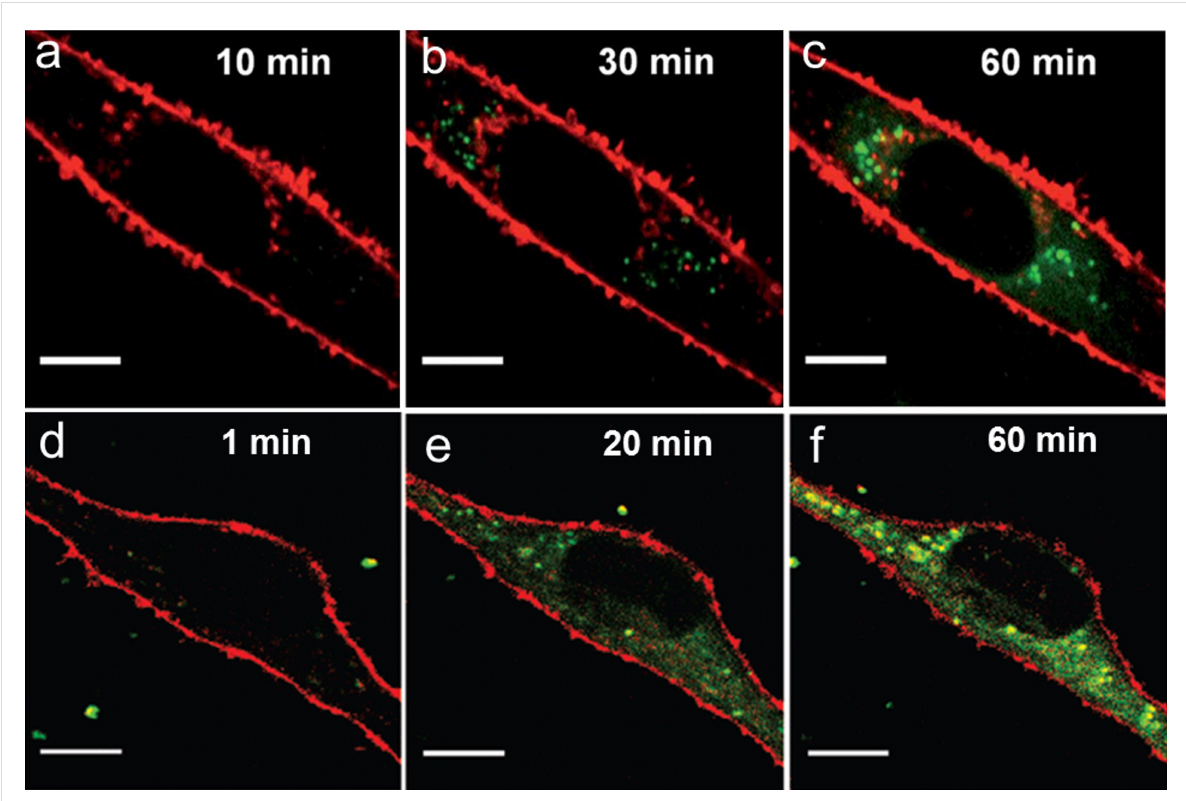
Figure 4: Two-color merged confocal images of live human MSCs exposed to NPs (green) in PBS for different times. (a–c) PS − NPs, 75 µg/mL; (d–f) PS + NPs, 7.5 µg/mL. Scale bar, 10 µm. Cell membranes (in red) are stained with CellMask DeepRed. Images in panels a–c were reproduced with permission from [32]. Copyright 2011 Royal Society of Chemistry. Images in panels d–f were reproduced with permission from [33]. Copyright 2010 American Chemical